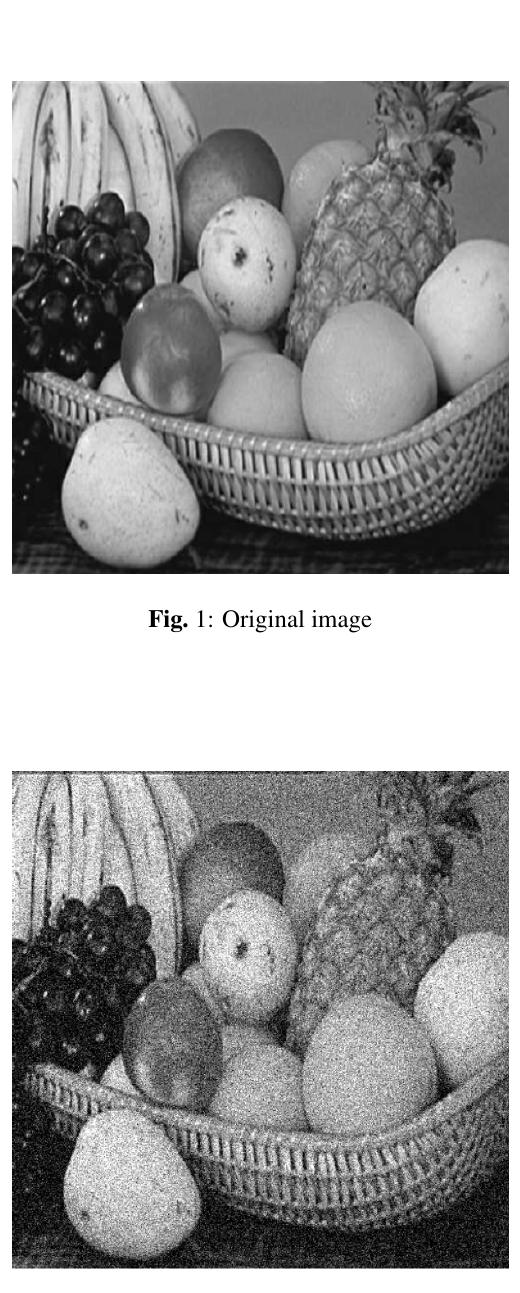
Fig. 2: Degraded image